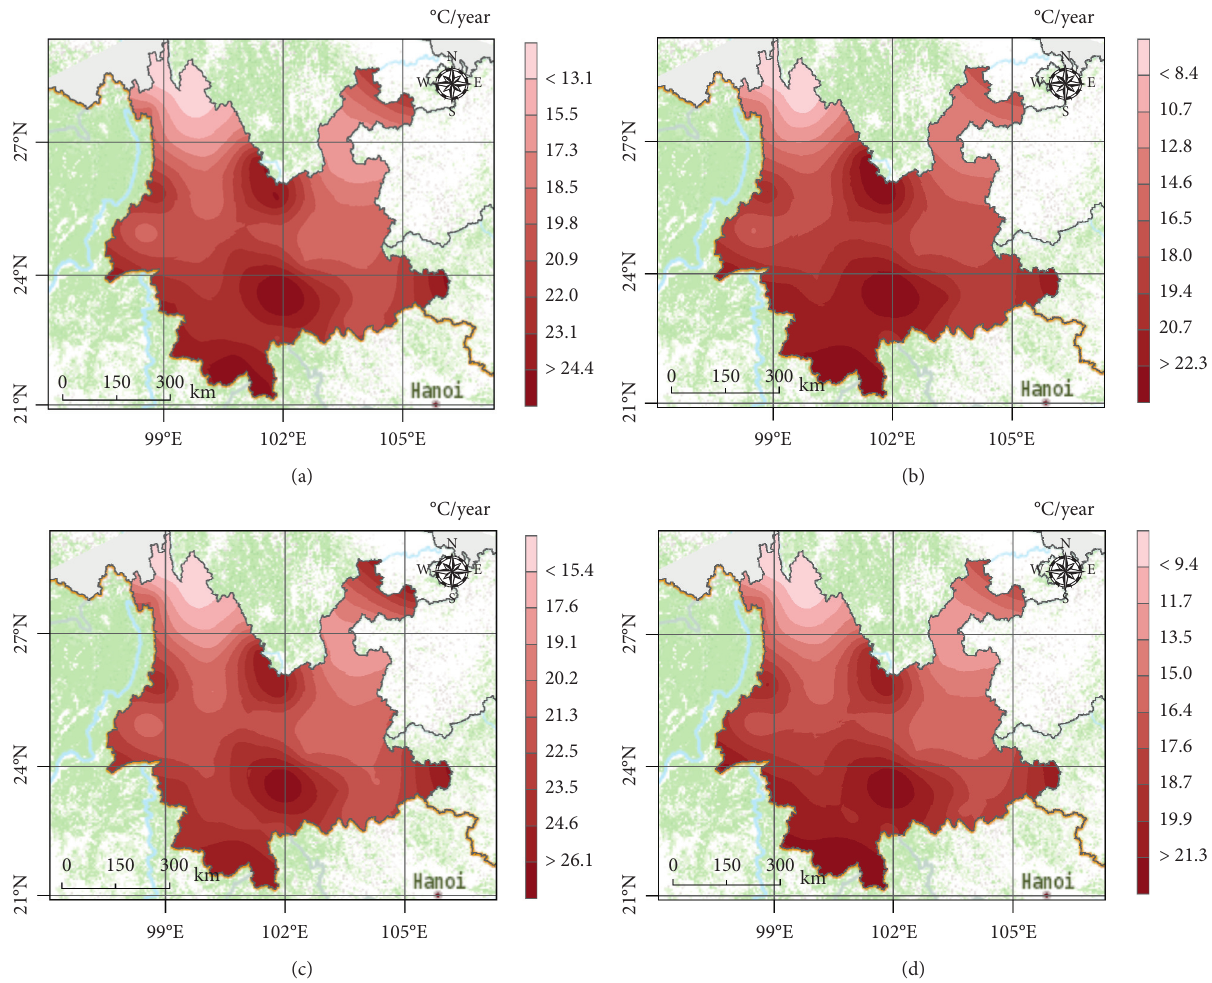
Figure 7: Spatial pattern of multiyear mean temperature in (a) growing season; (b) spring; (c) summer; (d)